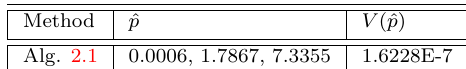
Table 13: Example 3.9. Results from step 2 in Alg. 2.1, i.e. optimal DIPTD model approximation, where c 1 = 0 and c 2 = 1.